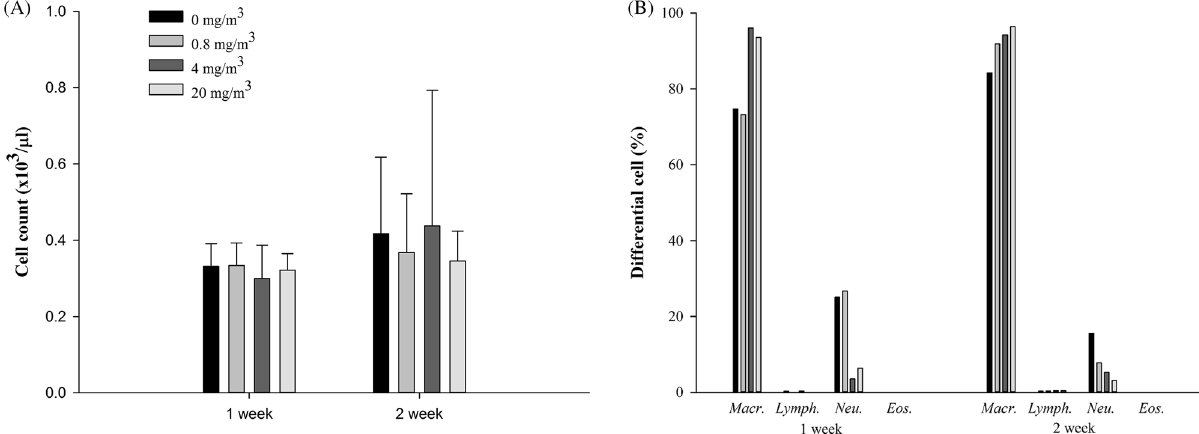
Figure 4. Total cell counts ( A ) and differential cell percentage ( B ) of total cells from bronchoalveolar lavage fluid (BALF) after NaDCC exposure. The values are expressed as mean ± SD (n = 5 males per